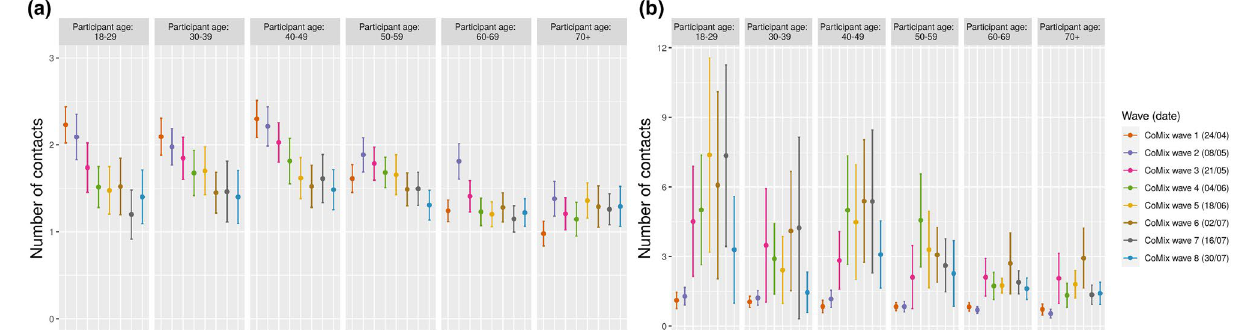
Figure 2. Home/away from home contacts. ( a ): Mean number of contacts at home. Errorbars mark the 95% CI.( b ): Mean number of contacts away from home. Errorbars mark the 95%